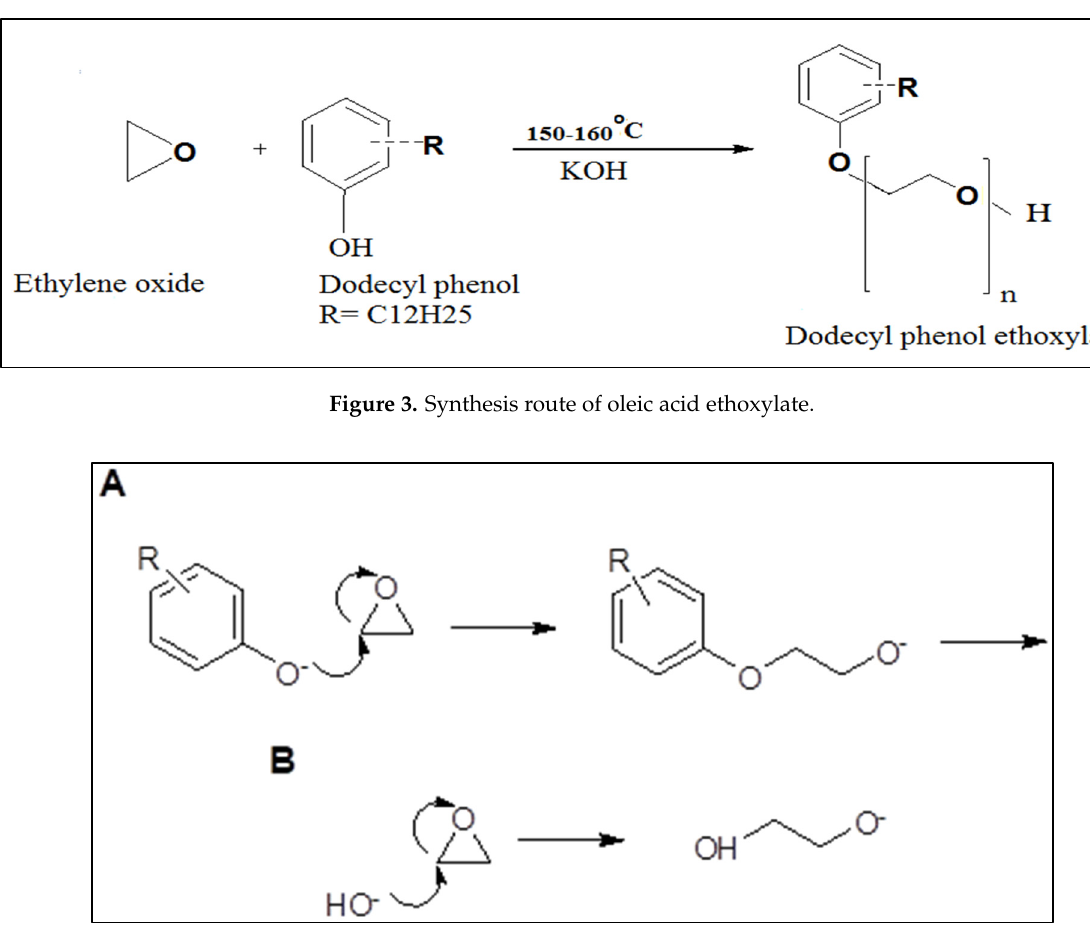
Figure 2. Synthesis approach for the preparation ofDodecyl phenol ethoxylate.